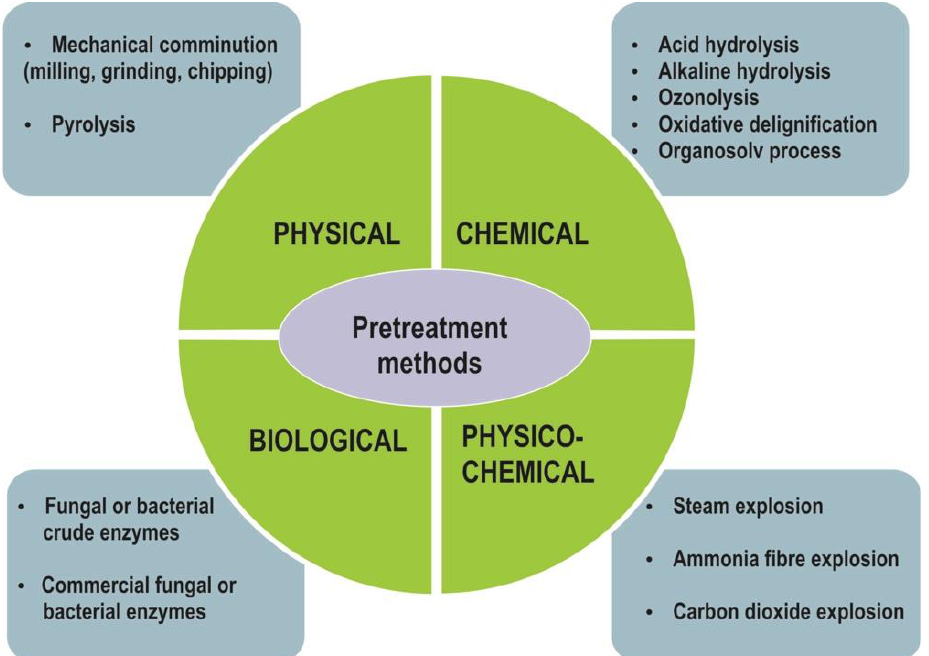
Figure 5. Different pretreatment methods of lignocellulosic materials for saccharification before the fermentation process (Adapted from Rawoof et al. (2020) [29]).